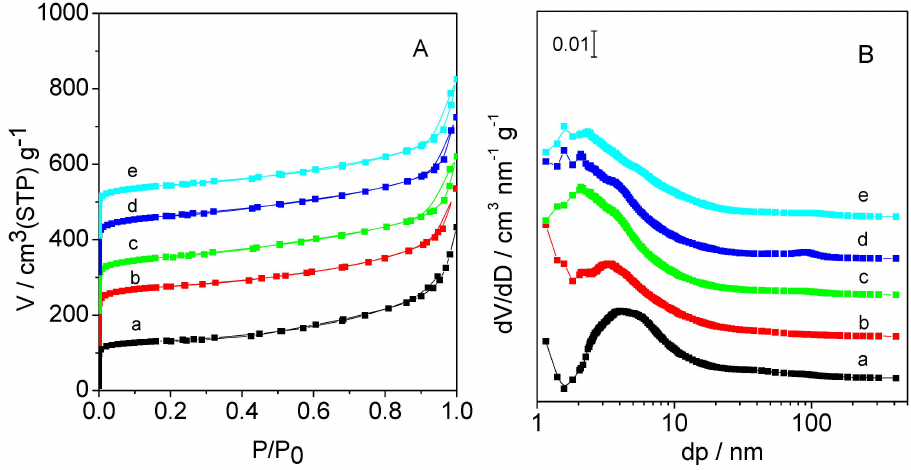
Figure 4. N 2 adsorption and desorption isotherms ( A ) and pore size distribution ( B ) of HB(12) ( a ); HB(77) ( b ); HB(77)-NT(1 M, 1 h) ( c ); HB(77)-NT(2 M, 1 h) ( d ); and HB(77)-NT(2 M, 16 h) ( e )